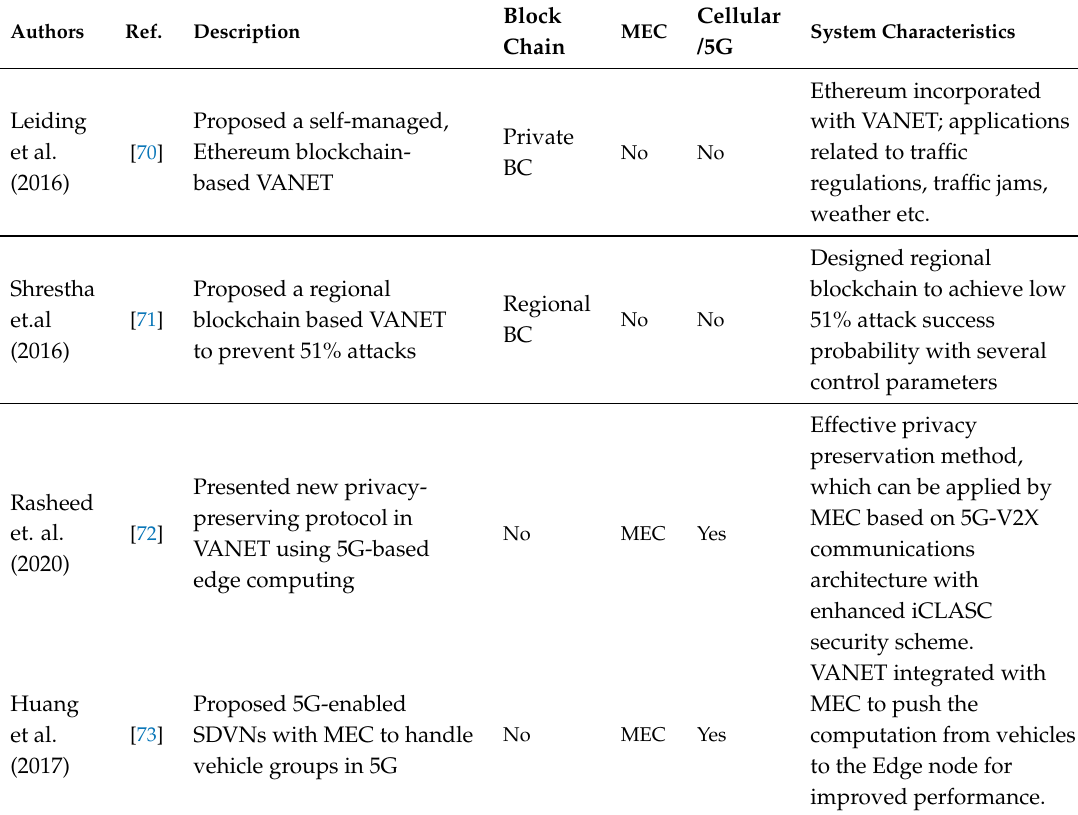
Table 7. A comparative study of blockchain with 5G and edge